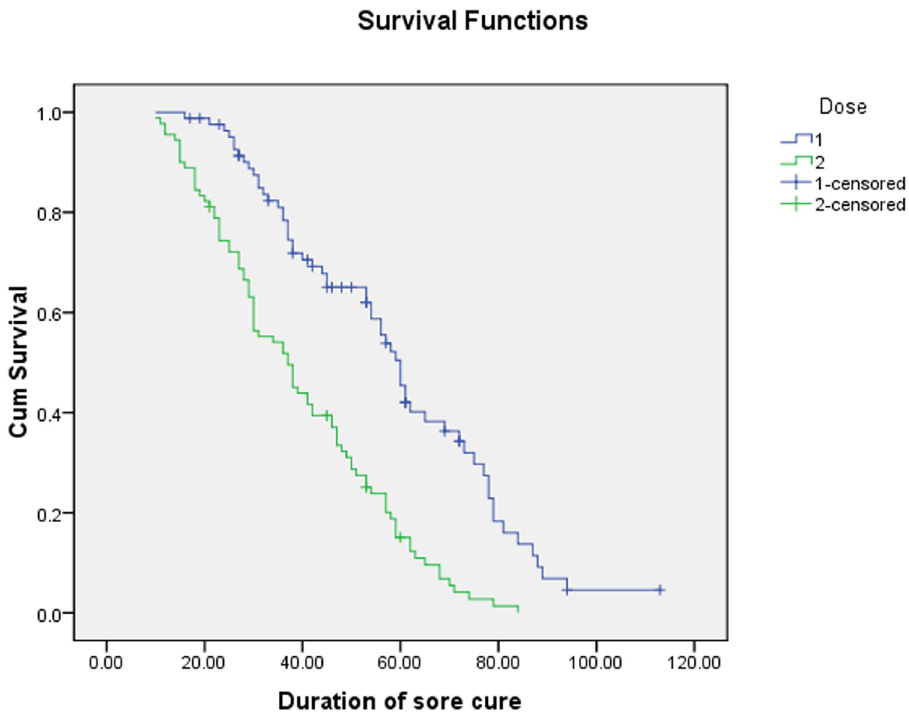
Fig 2. Survival function of sore cure separate by dose